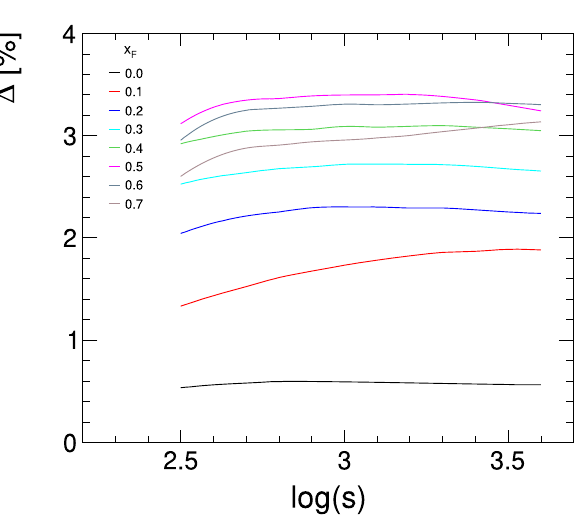
Fig. 176 (cid:4) p T (cid:5) of π − as a function of x F for 7 values of log ( s ) from 1 to 3.6